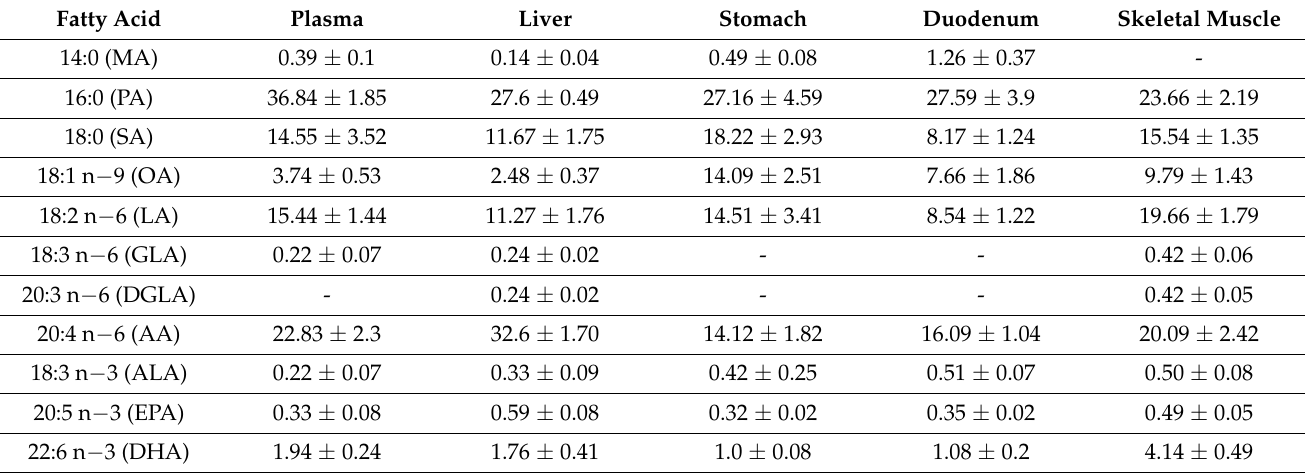
Table 1. Fatty acid composition phospholipid fraction of different types of cells/tissues of Wistar rats. This data is taken from Manjari, V., Das, U. N. (2000) Prostaglandins Leukot. Essen. Fatty Acids. 62, 85–96., and Mohan IK, Das UN. (2001) Nutrition. 17, 126–151 (references 1 and 2 under references